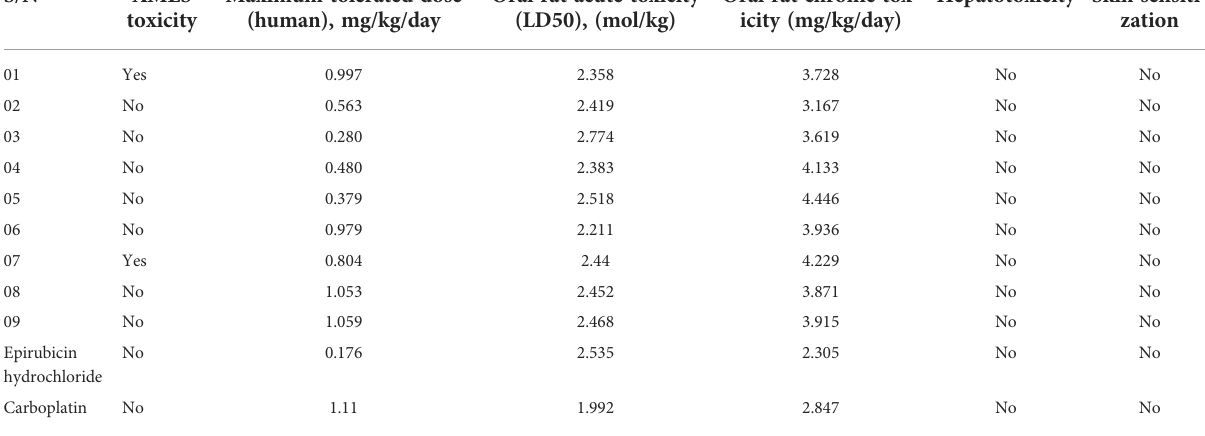
TABLE 5 Aquatic and non-aquatic toxicity value